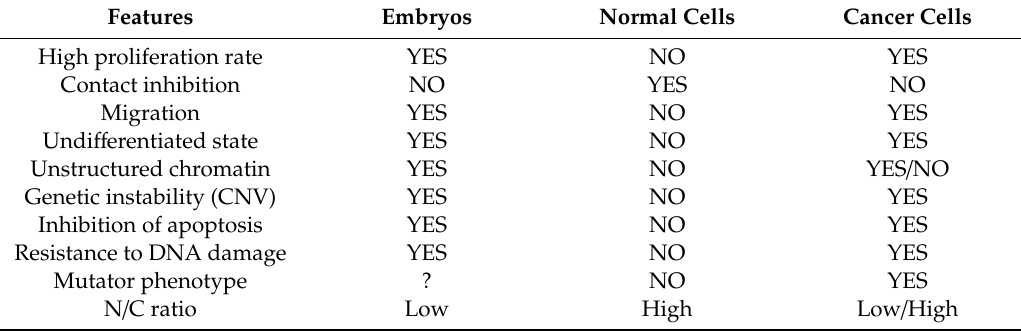
Table 2. Features shared between early embryos, normal non-cancer and cancer cells. Unstructured chromatin features can be variable in cancer cells, with certain cancer cells having more structured chromatin than others do. N / C: nucleus to cytoplasm volume ratio. This can be variable in di ff erent cancer cells types and at di ff erent stages of malignant transformation.